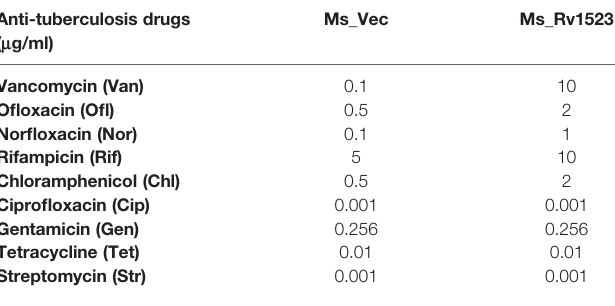
TABLE 2 | Drug sensitivity to anti-tuberculosis drugs. Anti-tuberculosis drugs ( m g/ml)